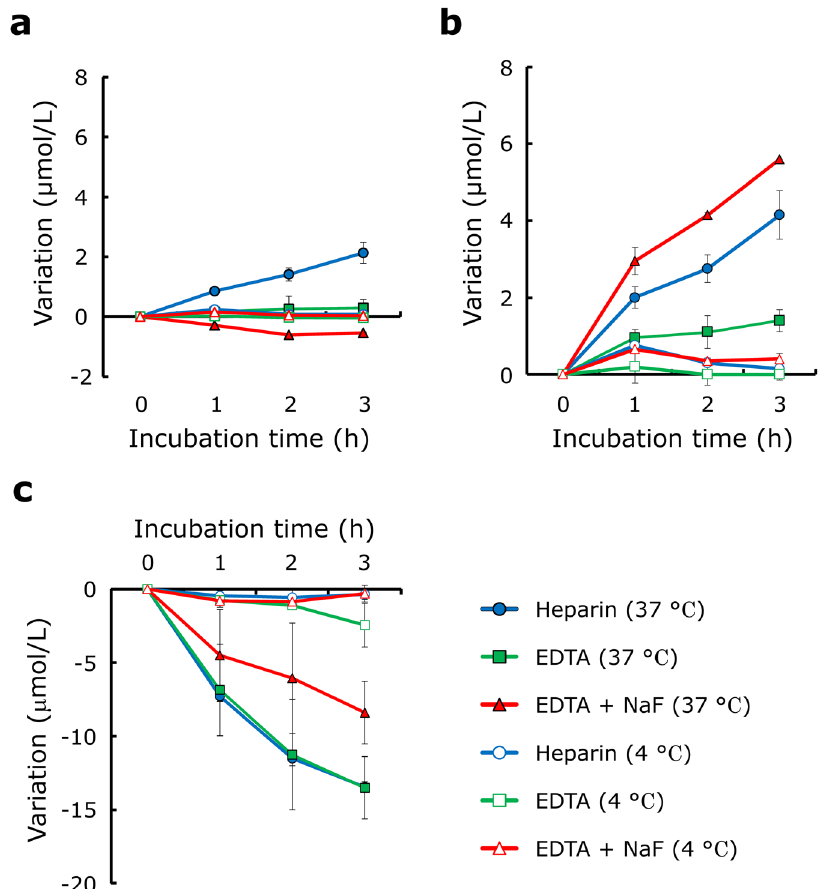
Figure 2. Variations in plasma choline and LPA levels obtained from whole blood with the addition of various anticoagulants. Whole blood obtained from healthy human subjects was mixed with heparin (blue), EDTA-2K (EDTA)(green), or EDTA-2K and NaF (EDTA + NaF)(red), then incubated at 37 °C (closed mark) or 4 °C (open mark) for 1 to 4 hours. After the plasma samples were collected by centrifugation at 4 °C, the concentrations of LPA ( a ) and choline ( b ) were measured in each plasma sample. ( c ) Eighty-micromolar choline chloride was added to whole blood with heparin, EDTA-2K (EDTA), or EDTA-2K and NaF (EDTA + NaF), then incubated at 37 °C or 4 °C for 1 to 4 hours. After the plasma samples were collected by centrifugation at 4 °C, the concentrations of choline were measured in each plasma sample. Results are given as the mean ± SD (n =